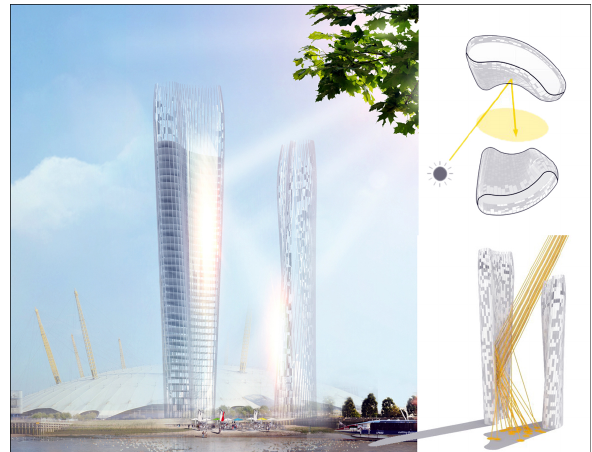
Figure 1. No-shadow tower concept by Christian Coop, NBBJ, 2015, by: